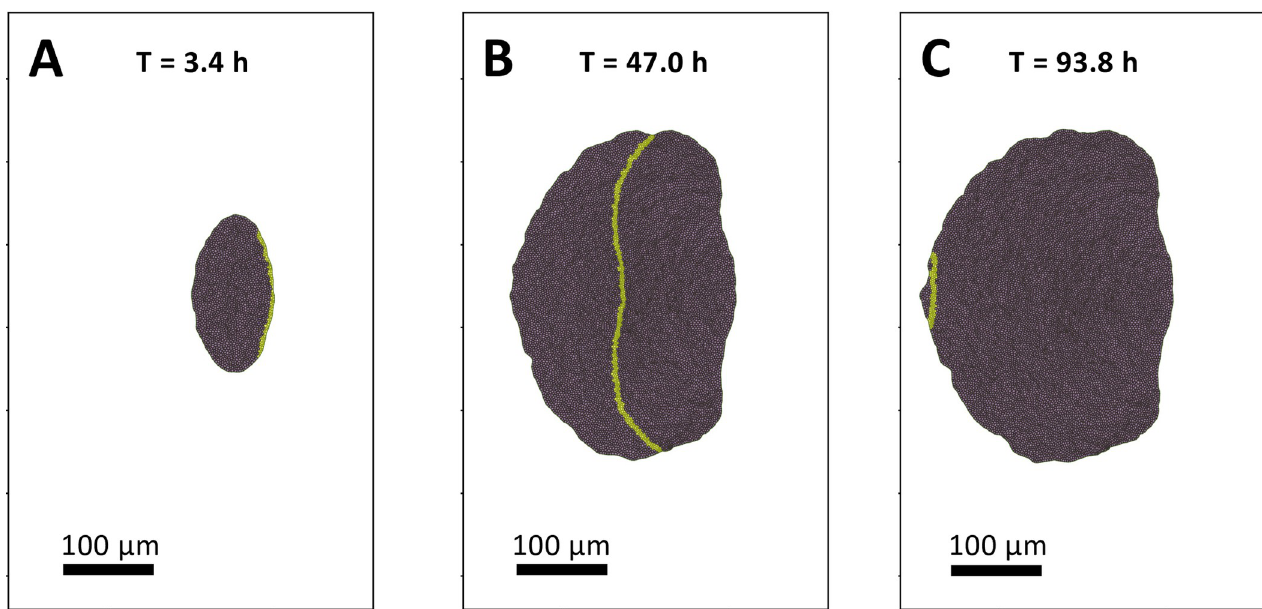
Fig 6. Drosophila eye disk tissue at different times of growth. A-C: Vertex model simulation of tissue growth, with cells in the MF highlighted in yellow. A: Time T = 3.4 h ; the MF is initialized at the posterior tissue boundary. B: Time T = 47.0 h ; the majority of cell divisions have taken place, while the MF has linearly propagated to the bulk of the tissue. C: The MF reaches the anterior boundary of the tissue, signaling the cell cycle arrest of all cells and termination of growth.